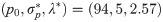
Node activities in the (a) WM and (b) CM. Although the spikes have different forms between models and the CM shows higher noisy activity, both models identify the same set of nodes as having a larger propensity to spike. The network is the same for both models, a directed random network with N = 10 nodes and mean degree c = 1.6. Parameters: (p0,σp*,λ*)=(94,5,2.57) and (I,σI*,w*)=(−1.2,5,1.6).